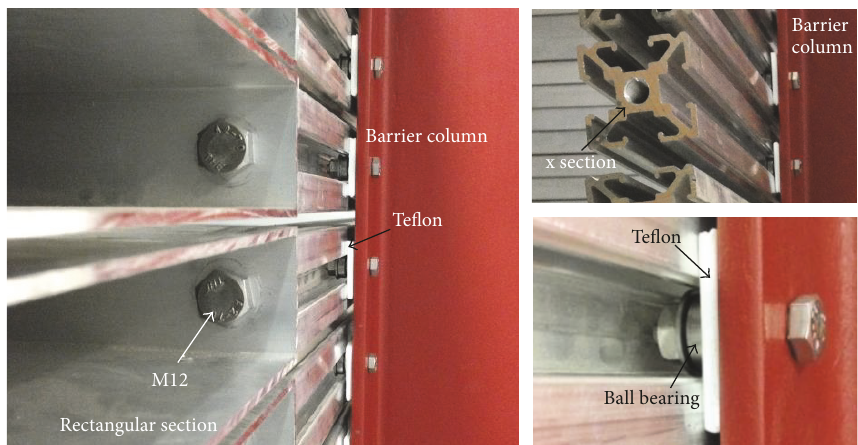
Figure 3: Construction of the laminar layers.